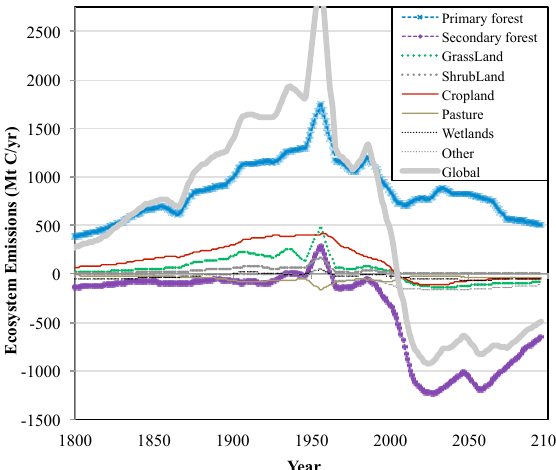
Fig. 1. Annual land-use change emissions (MtCyr − 1 ) by ecosystem from the G-Carbon model (smoothed by 9yr